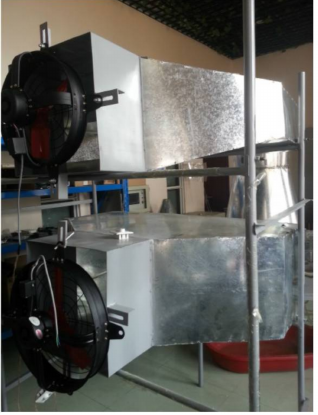
Figure 2. Environmental natural wind simulation